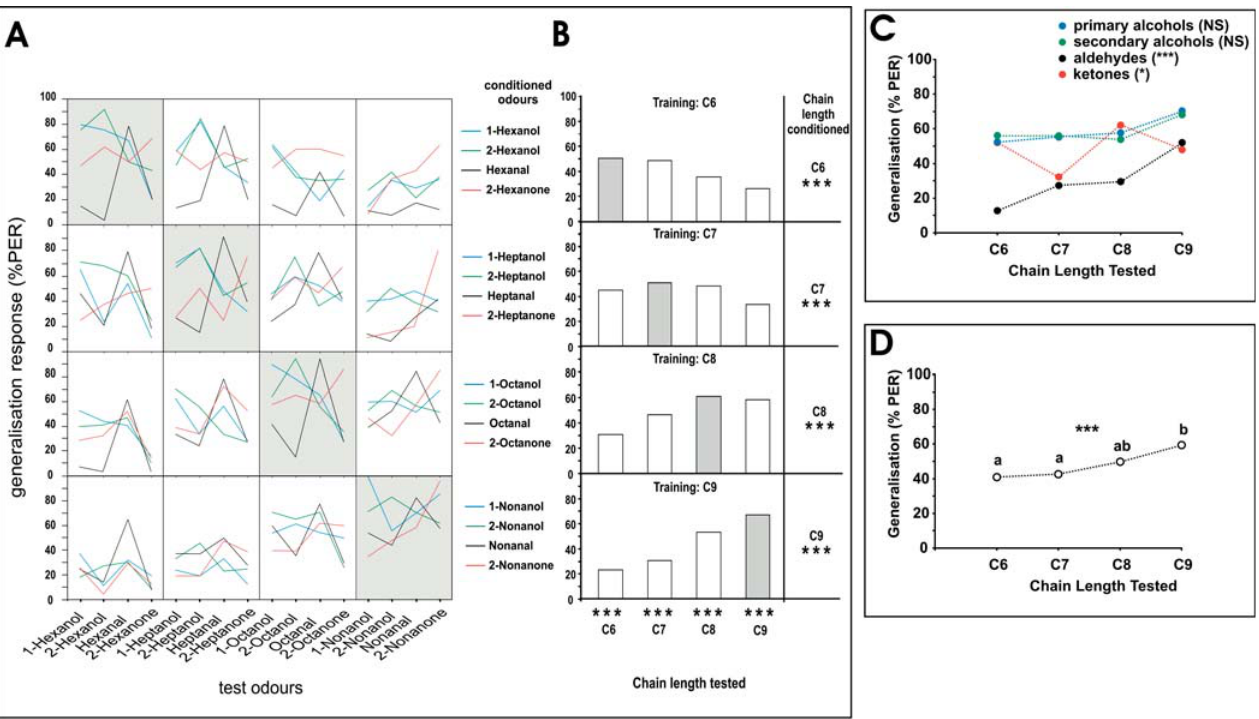
Figure 4. Generalisation Depending on Chain Length (A) Data of the generalisation matrix (see Figure 2) represented as two-dimensional graphs for each conditioned odour. The right ordinate represents the CSs categorised in four chain lengths, C6, C7, C8, and C9 molecules (from top to bottom). The abscissa represents the test odours aligned in the same order as the conditioned odours (from left to right). The left ordinate represents the percentage of proboscis extensions to the test odours after being trained for a given odour. Each quadrant in the figure represents generalisation responses to one chain length after training for the same (grey quadrants) or to a different chain length (white quadrants). (B) Same data as in (A), but the observed responses within each quadrant were pooled and the resulting percentage of responses per quadrant was calculated. The abscissa and the right ordinate represent the four chain-length categories. The left ordinate represents the percentage of proboscis extensions to each of these categories after being trained for a given chain-length category. Grey bars correspond to grey quadrants in (A) and represent generalisation to the same chain length as the conditioned one. White bars correspond to white quadrants in (A) and represent generalisation to a chain length different from the conditioned one: C6, C7, C8, and C9 mean chain length of 6, 7, 8, and 9 carbons, respectively. Asterisks indicate significant differences along a row or a column ( p , 0.001). (C) Within chain-length generalisation as depending on functional group. The abscissa represents the chain lengths tested. The ordinate represents the percentage of proboscis extensions to the same chain length after being trained to a given functional group (lines). Thus, the first point to the left for ketones (red circles) represents generalisation to 1-hexanol, 2-hexanol, and hexanal after conditioning to 2-hexanone; the second point represents generalisation to 1-heptanol, 2-heptanol, and heptanal after conditioning to 2-heptanone. A significant heterogeneity was found in within-chain-length generalisation for aldehydes and ketones. (D) Generalisation within-chain lengths. The figure results from pooling the data of (C) corresponding to each chain length. Each point shows the percentage of proboscis extensions to odours of the same chain length as the conditioned odour. Within-chain-length generalisation was significantly heterogeneous (asterisks, p , 0.001). Pairwise comparisons showed that generalisation within C9 molecules was significantly higher than within C7 and C6 molecules and marginally higher than within C8 molecules (different letters indicate significant differences). DOI: